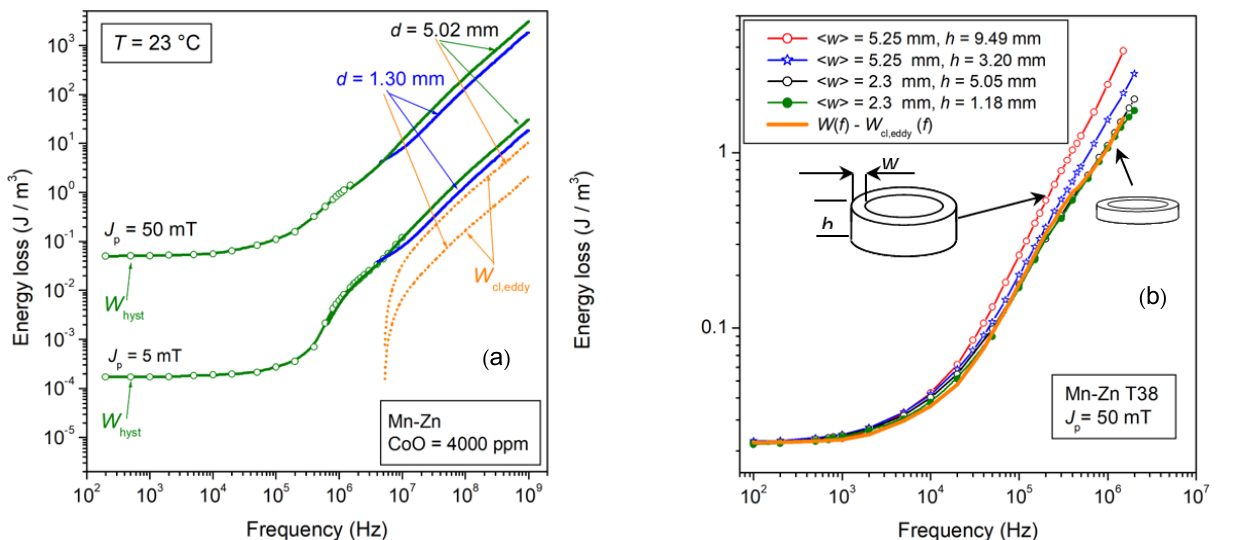
Figure 4. ( a ) Energy loss W ( f ) versus frequency in a CoO-doped Mn-Zn ferrite ring and its dependence on the sample thickness d . With d reduced from 5.02 mm to 1.30 mm, W ( f ) is affected, beyond a few MHz, by the decrease in the eddy current losses W cl,eddy ( f ), which attain vanishing values. Such a decrease is predicted by means of a simplified Equation (10) (dashed lines). ( b ) Very large and thick low-resistivity T38 Mn-Zn ring samples can be affected by the eddy current losses already in the kHz range. In such a case, W cl,eddy ( f ) is calculated through Equation (9) and, once subtracted from the measured W ( f ), the eddyfree energy loss curve W h + W r ( f ) (solid line) is obtained. (Partly adapted from Ref. [24]).